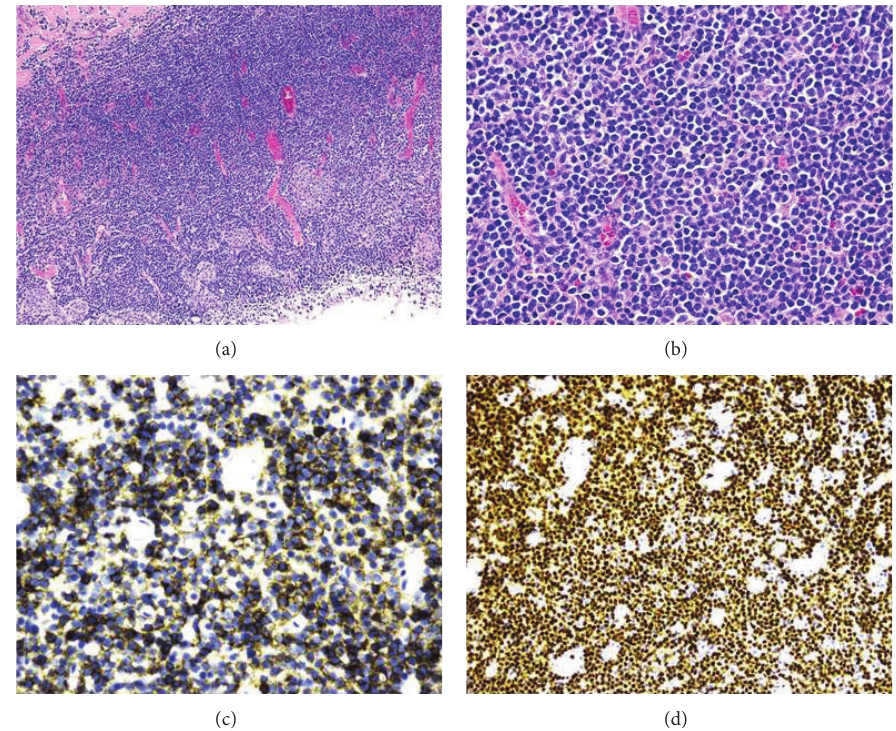
Figure 1: (a) Low power images of H&E stain show infiltration of the bladder wall by small plasmacytoid lymphocytes. (b) High power images of H&E stain show infiltration of the bladder wall by small plasmacytoid lymphocytes. (c) CD20 stain shows positive cells. (d) PAX-5 stain shows diffusely positive cells.